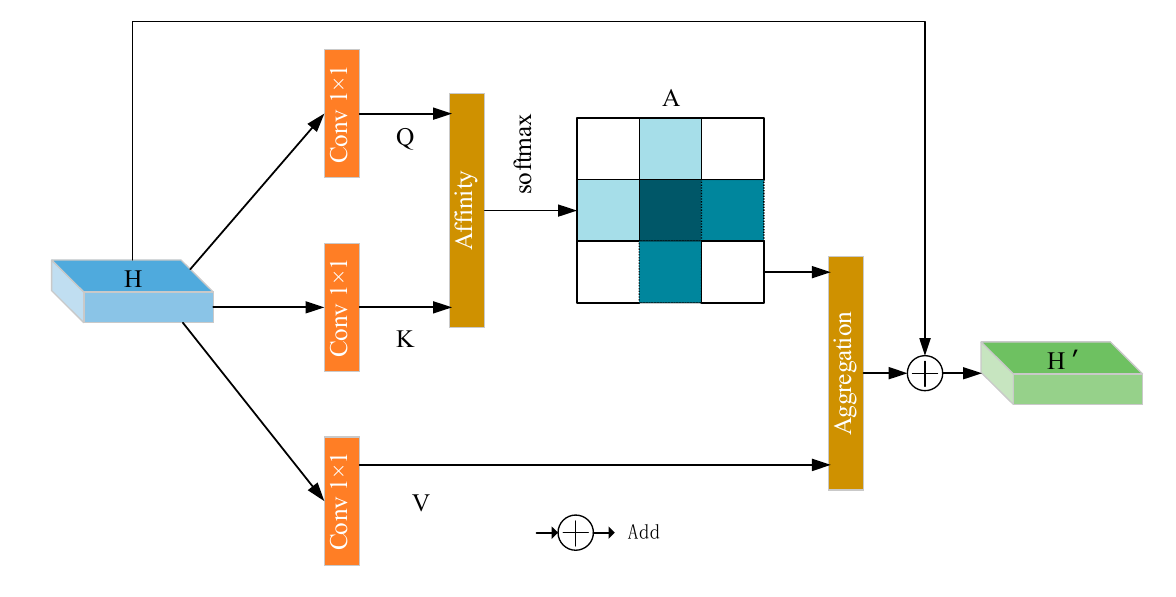
Figure 5. Structure of the attention module.